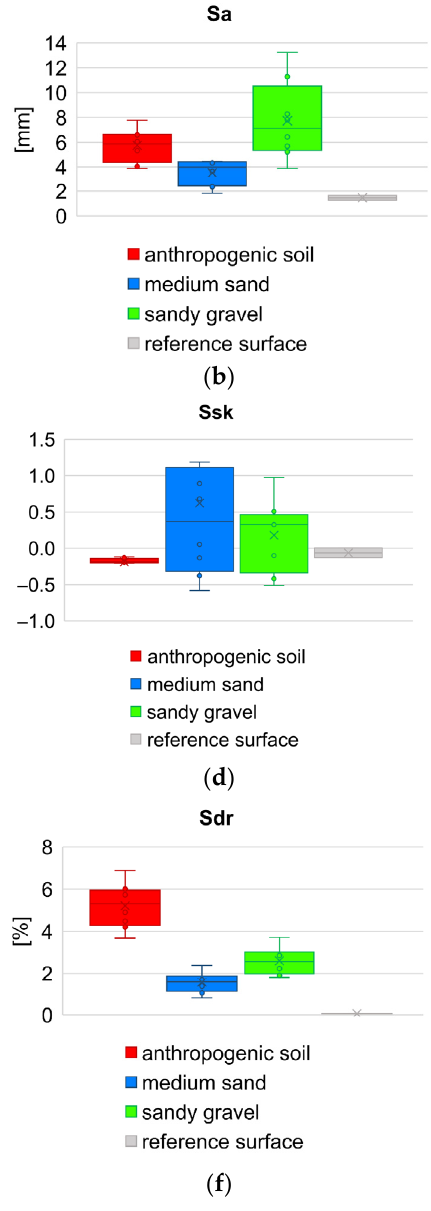
Figure 14. Box plot comparison of height and hybrid parameters of the concrete surface: ( a ) maximum height; ( b ) arithmetical mean height; ( c ) root mean square height; ( d ) skewness; ( e ) kurtosis; ( f ) developed interfacial area ratio.